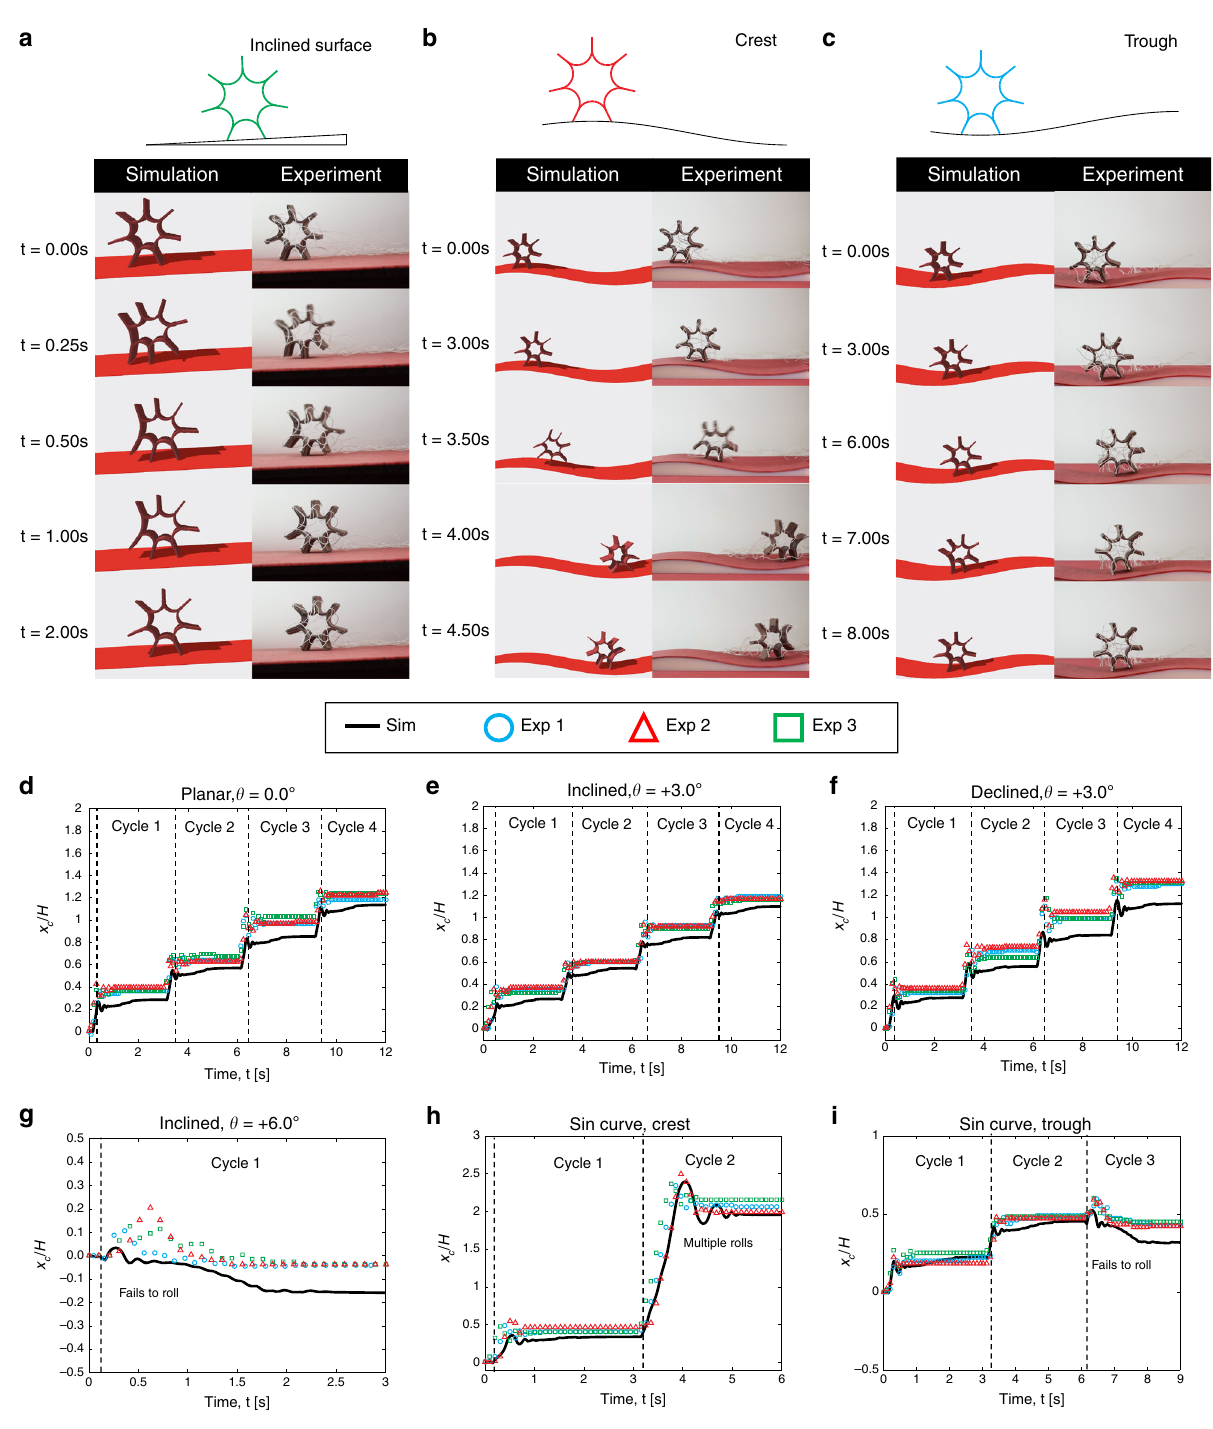
Fig. 5 Snapshots of rolling robot in different scenarios. a Inclined surface ( θ = + 3.0°), b Crest of sinusoidal surface, and c Trough of sinusoidal surface. Normalized x coordinate of the robot centroid with time from experiments (symbols) and simulations (solid lines): d planar surface, θ = 0.0°; e inclined surface, θ = + 3.0°; f declined surface, θ = − 3.0°; g inclined surface, θ = + 6.0°; h sinusoidal surface, crest; and i sinusoidal surface,